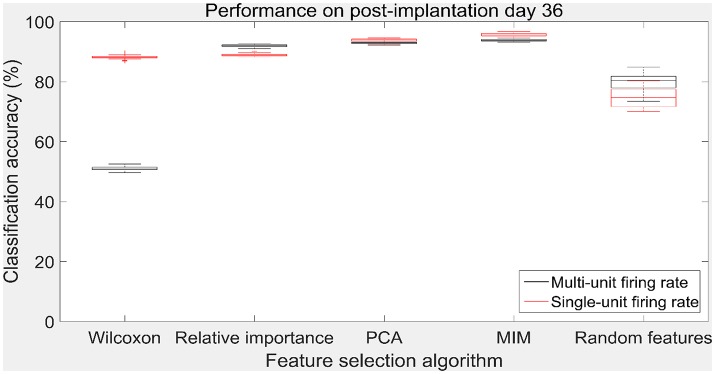
Accuracy of neural decode on post-implantation day 36. Classification accuracy of feature selection algorithms on the test set using cross validated optimal number of features. The plots in black and red correspond to classification accuracy obtained using multi-unit firing rate and single-unit firing rate respectively. Level of chance was 10% (10 degrees of freedom). The central box represents the central 50% of the data with the top and bottom sides of the central box representing the 75% quantile and 25% quantile respectively. The central line in the central box represents the median of the central 50% of the data. The vertical lines extending above and below the central box represent the remaining data that are not regarded as outliers.